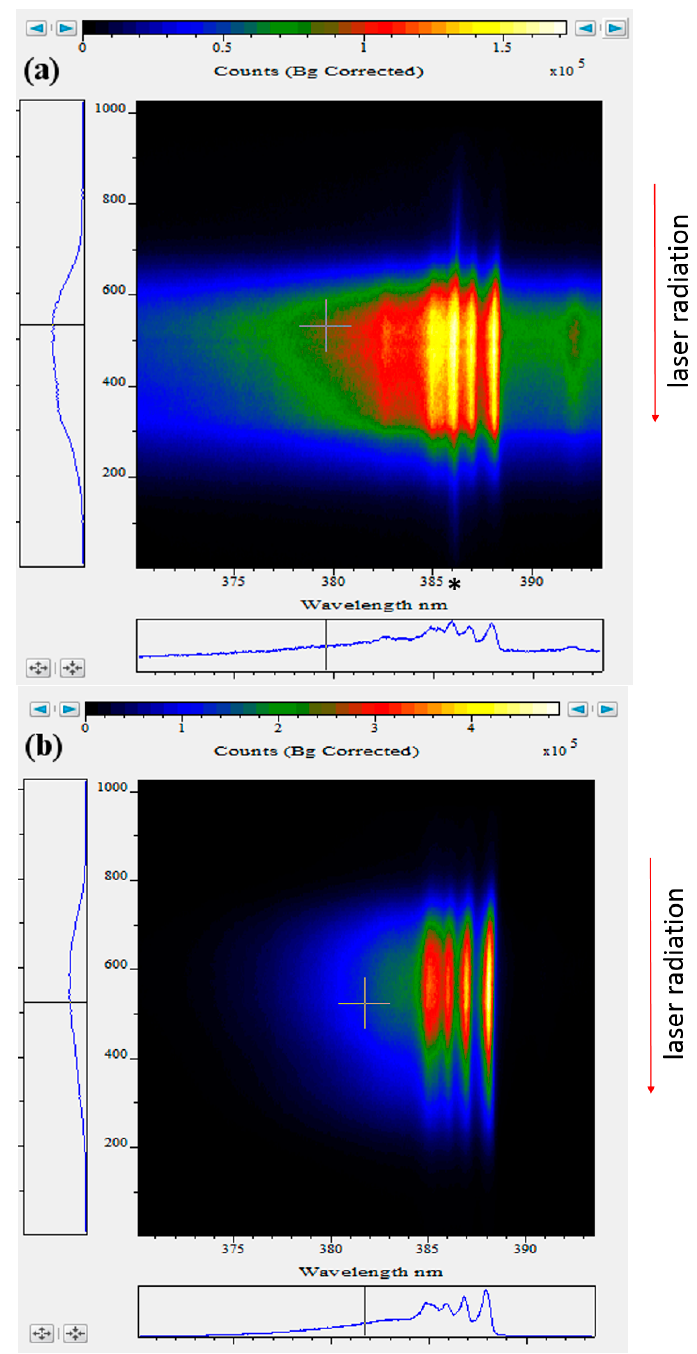
Figure 3. Raw spectra ( a ) 0.45 µs and ( b ) 3.7 µs after optical breakdown in a 1:1 CO 2 :N 2 gas mixture at 1 atm. The asterisk near 386.2 nm indicates in ( a ) the carbon line measured in 2nd order [15]. This carbon line dominates the spectra in ( a ) near the edges at pixel heights of 200 and 600, but ( b ) shows only well-developed CN spectra.